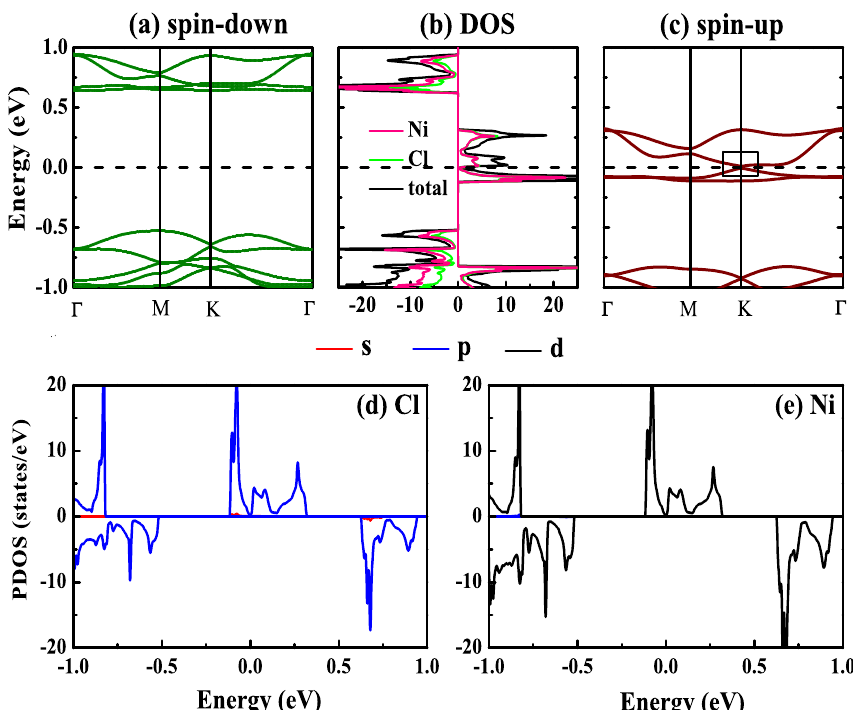
Figure 2. ( a , c ) are the calculated band structure for spin-down and spin-up channels of NiCl 3 monolayer, respectively. ( b ) is the total DOS and atom-resolved local DOS. ( d , e ) are the project DOS for the Ni and Cl